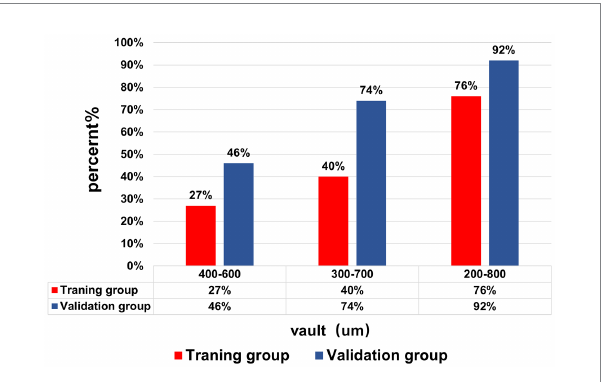
FIGURE 3 The achieved vault of the training group and validation group.